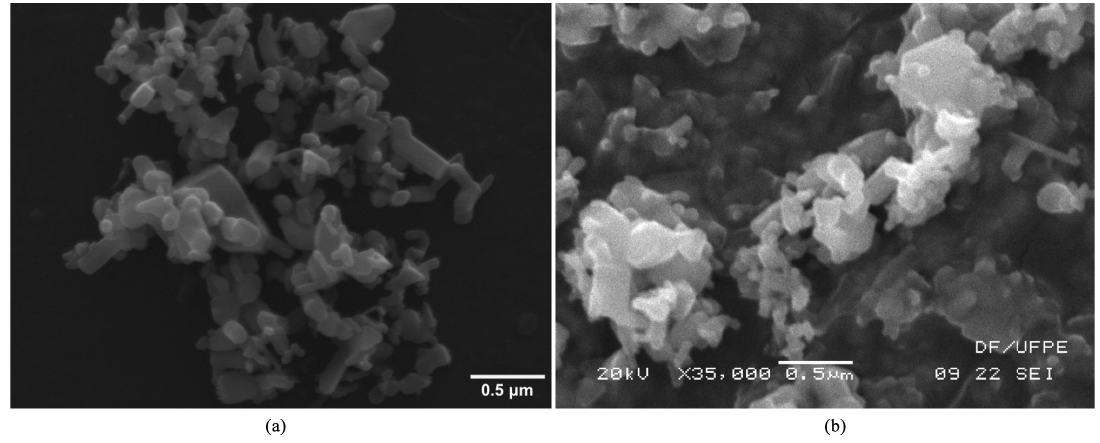
Figure 1. SEM image of: (a) ZnO_NPs and (b) ZnO_NPs/PPy nanocomposites.